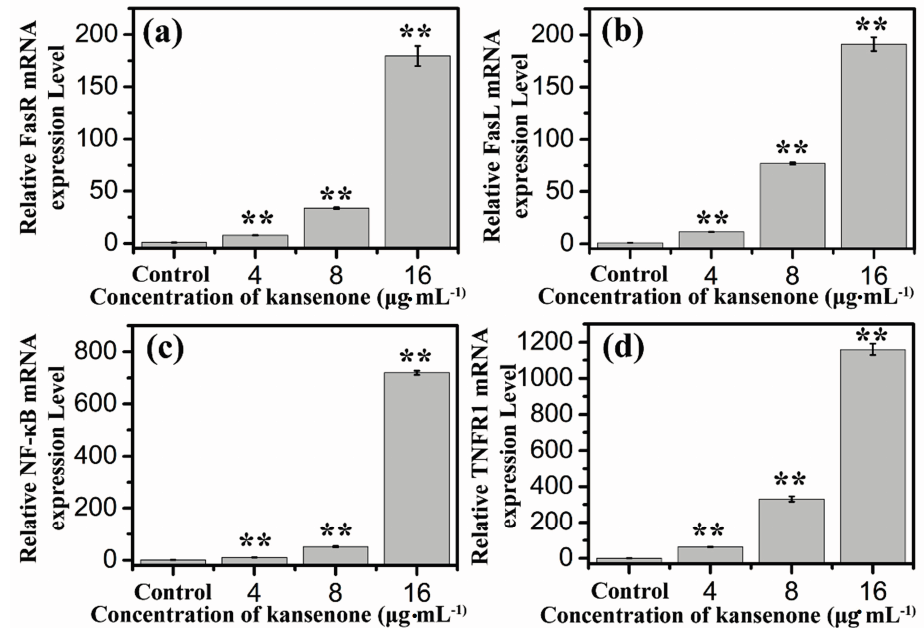
Figure 11. Effects of kansenone on ( a ) FasR; ( b ) FasL; ( c ) NF- κ B and ( d ) TNFR1 mRNA expression level after treatment with kansenone for 48 h. Compared with corresponding control group, ** p < 0.01.